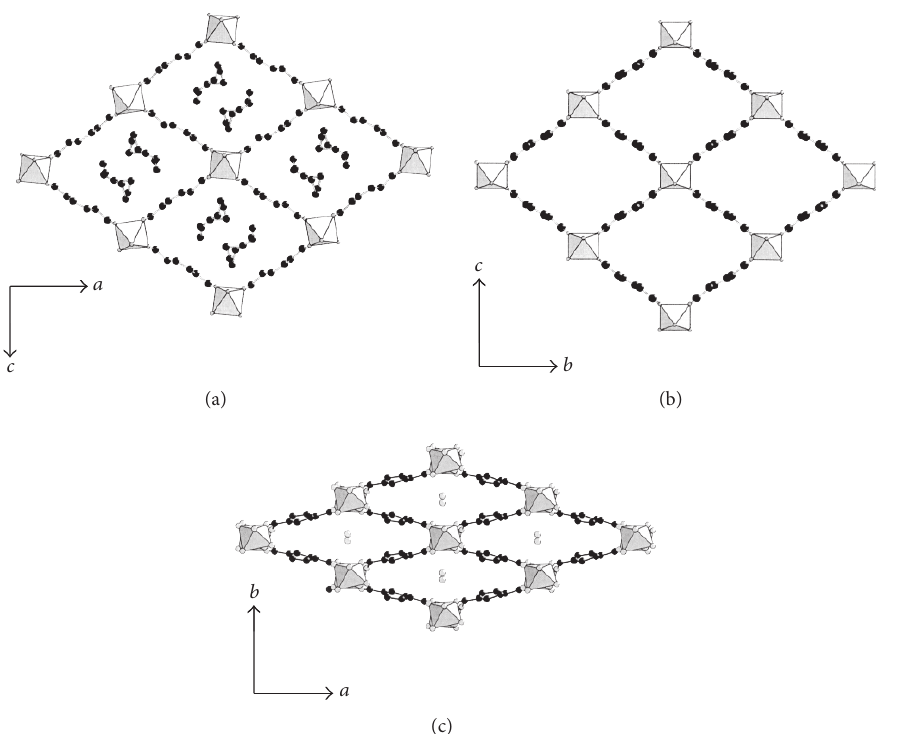
Figure 1: 3D structure of MIL-53 (Al) in three different states: (a) as-synthesized MIL-53(Al) or MIL-53 as (Al), where two disordered 1-4 benzenedicarboxylic acid molecules are inserted in the channel; (b) calcined MIL-53 ht (Al), where the channel is empty; (c) water saturated MIL-53 lt (Al), where one water molecular locates in the channel. Reprinted with permission from Ref. [8]. Copyright 2004 John Wiley and Sons.